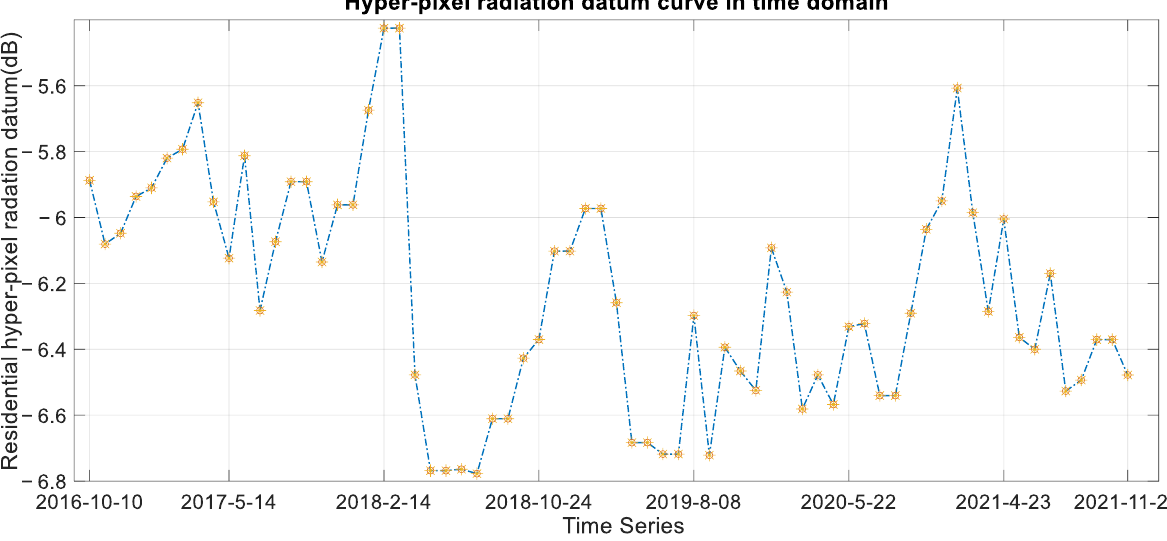
Figure 6. The radiation-data curve of the hyper-pixel set.